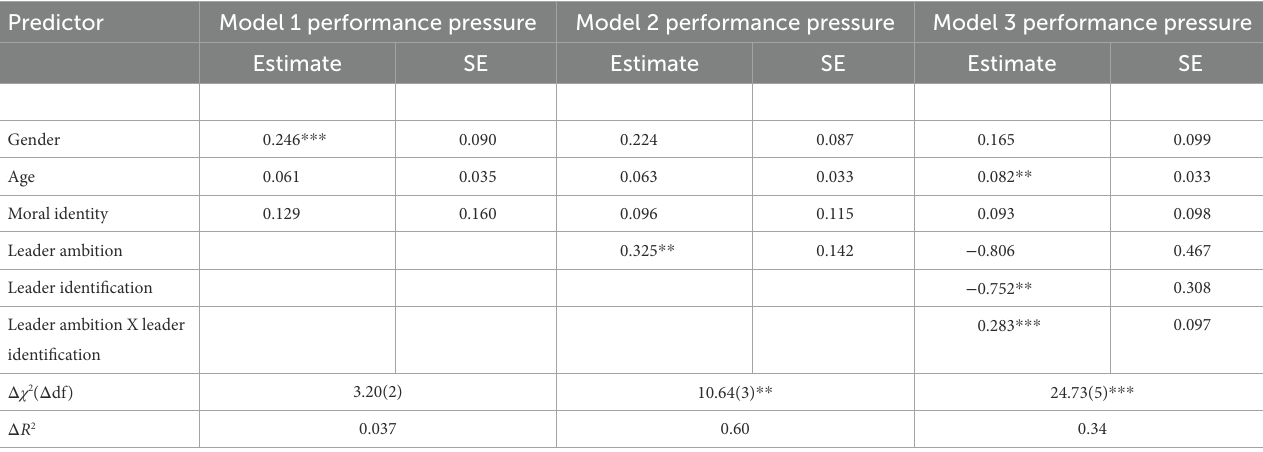
TABLE 2 Study 1- regression analyzes.